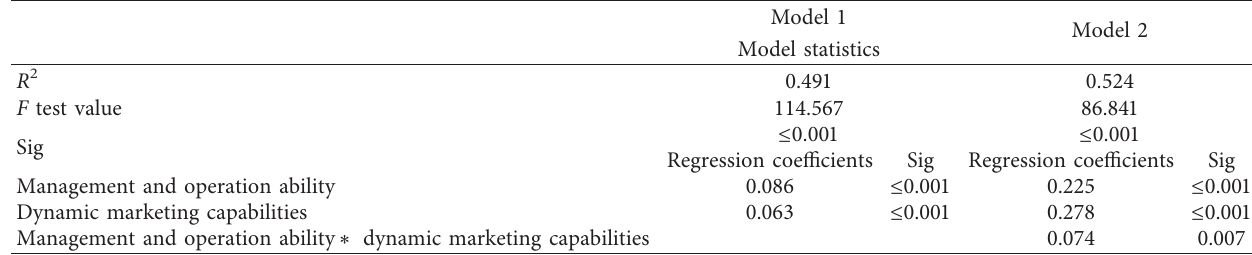
Table 6: Analysis of the adjustment effect of dynamic marketing capabilities (management and operation ability ➔ sustainable competitive advantage).